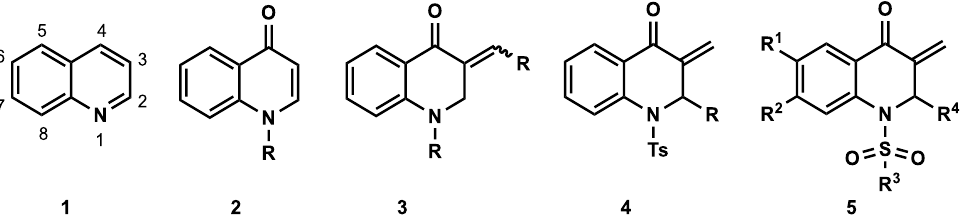
Figure 1. Chemical structure of quinoline, 4-quinolinones, and some diversely substituted analogs with quinolone skeleton.